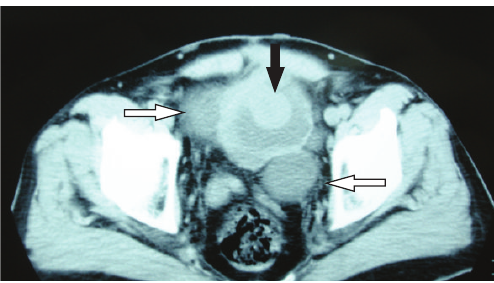
Figure 1: Computed tomography of the lower abdomen showing an exophytic lesion arising from the dome of the bladder (black arrow) and two large diverticulums (white arrows).